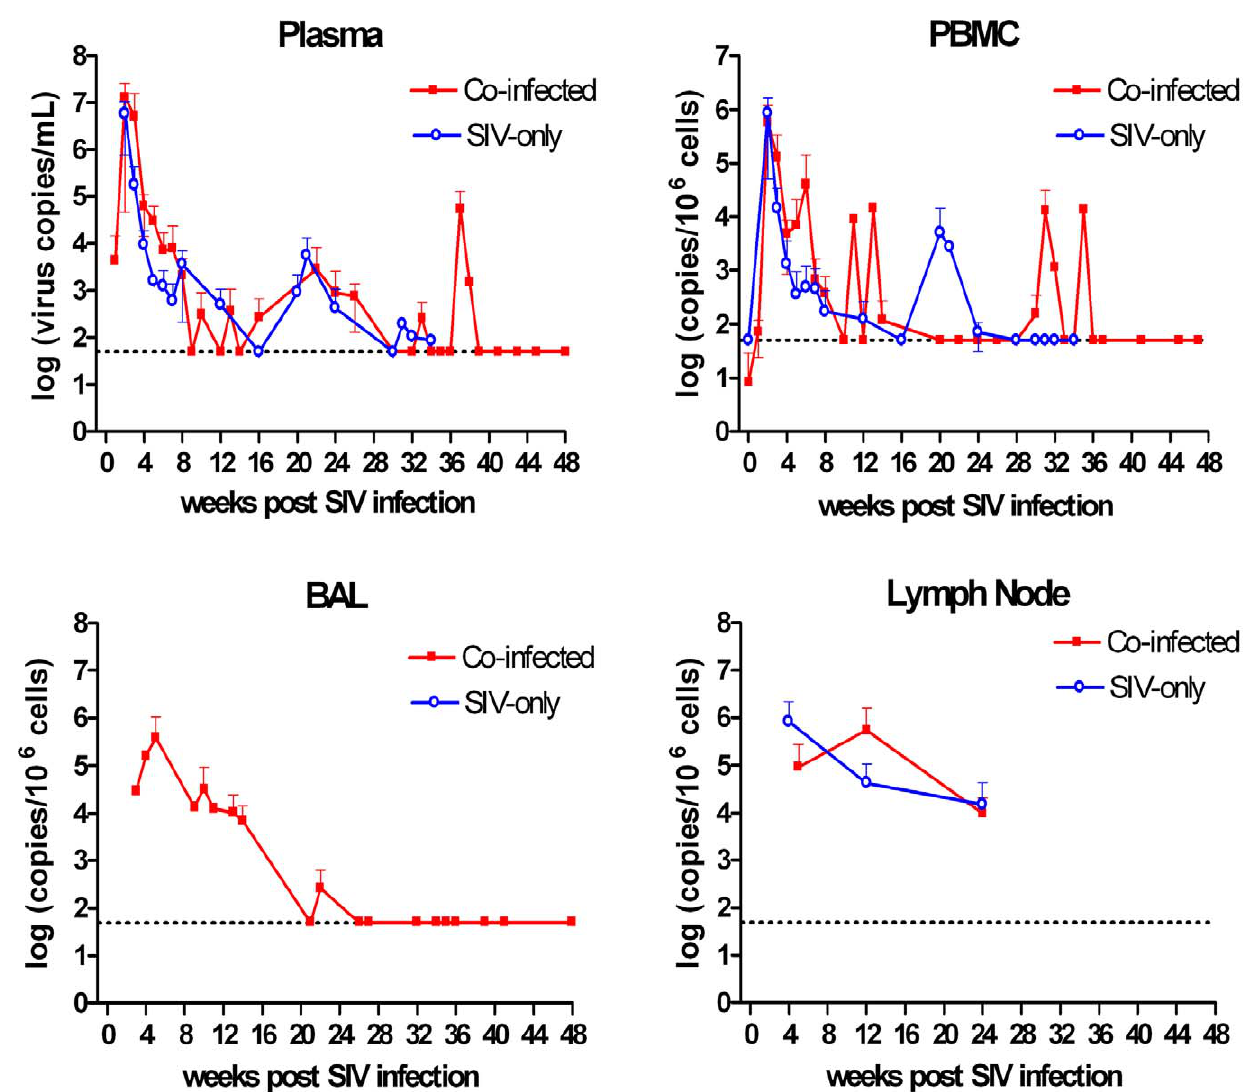
Figure 1. SIV loads in plasma and PBMC of Mtb-SIV co-infected and SIV-only monkeys. No significant differences in plasma, peripheral blood mononuclear cells (PBMC), bronchial alveolar lavage cells (BAL) or peripheral lymph node viral titer were observed between co-infected cynomolgus macaques (red line, n=7) or the SIV-only group (blue line, n=4). We were unable to obtain enough BAL cells from SIV-only monkeys to reliably measure virus load. The horizontal dashed line represents the detection limit for viral copy numbers. Lower error bars have been removed for